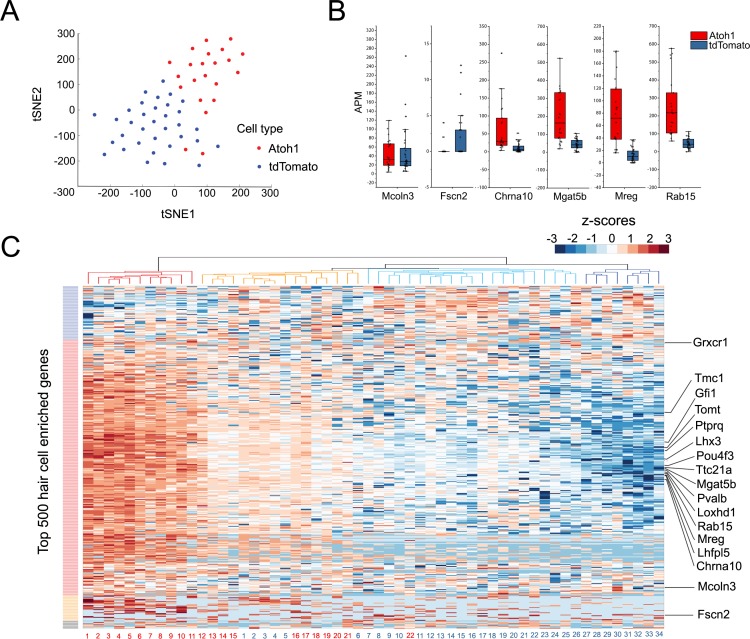
Single Cell RNA-seq analysis reveals heterogeneity in the response of supporting cells to hair cell death and Atoh1 transduction.(A) t-SNE analysis of single cells (n = 56) for Ad-tdTomato (n = 34) and Ad-tdTomato-Atoh1(n = 22) infected supporting cells using MATLAB. (B) Box-plot for verified hair cell specific genes, including hair cell genes that are not induced by Atoh1 virus infection (Mcoln3, Fscn2) and hair cell genes that are induced by Atoh1 virus infection (Chrna10, Mgat5b, Mreg, Rab15). APM: amplicon per million amplicons. (C) Heatmap showed hierarchical clustering of gene expression level between each single cells (Ad-tdTomato-Atoh1 infected cells labeled in red, and Ad-tdTomato infected supporting cell labeled in blue) for top 500 utricle hair cell enriched genes. Color code on the left suggested clustered genes population while on the top showing how each cells clustered together. Many hair cell genes that are previously identified are also showed in the heatmap.